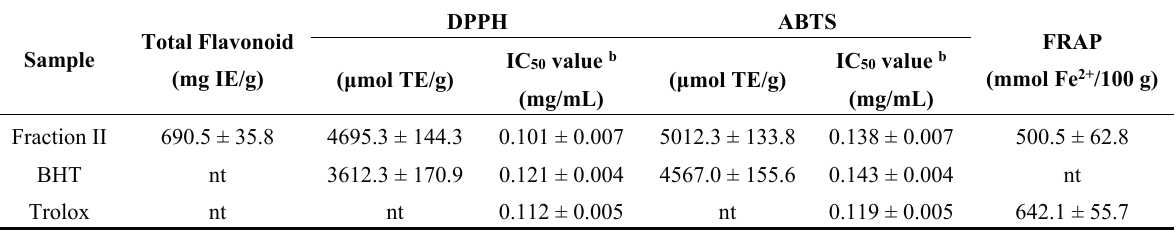
Table 2. Total flavonoids in fraction II from lotus leaves a and their corresponding antioxidant